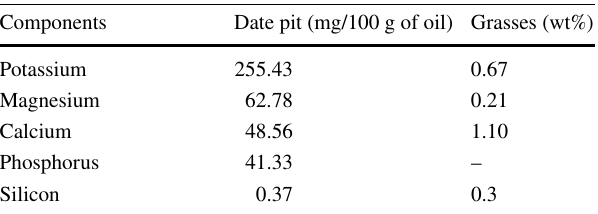
Table 3 Average mineral composition of some naturally occurring multicomponent polymers (Adewole and Sultan 2014; Wajheeuddin and Hossain 2017) Components